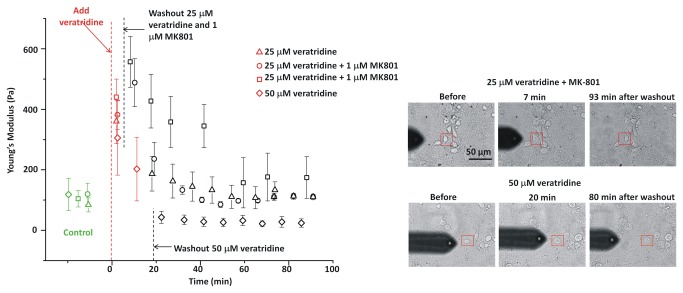
Neuronal stiffening upon exposure to veratridine.Neuronal somata “recovered” both optically and mechanically after treatment with 25 µM veratridine (with or without 1 µM MK801). The Young’s modulus of a neuron exposed to 50 µM veratridine decreased to below the initial value. Error bars are standard deviations for each neuron soma.